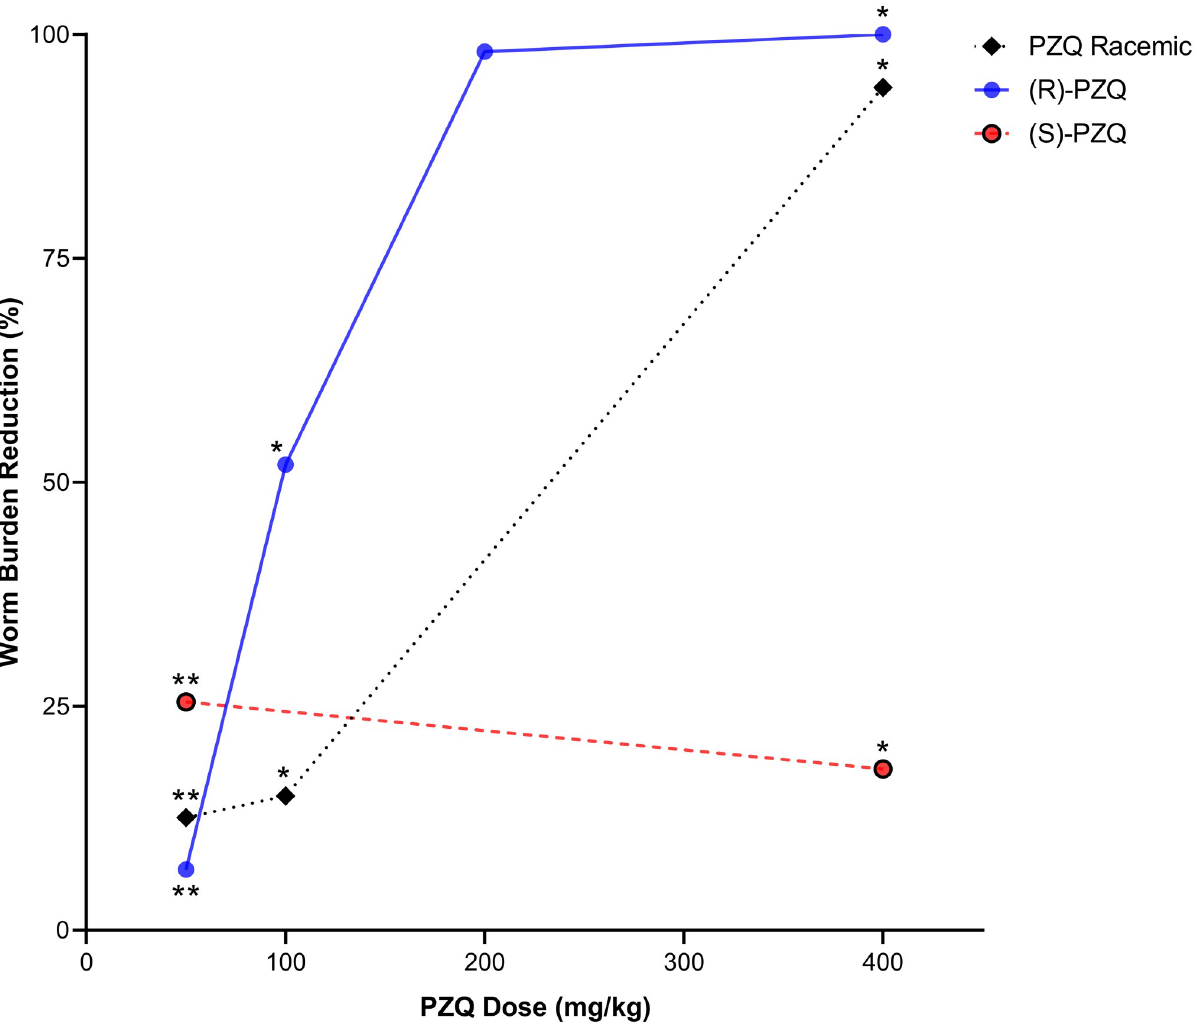
Fig 2. Comparison of the percentage WBR in an infected mouse model when dosing racemic PZQ or a single enantiomer. The data for this graph were extracted from two papers in this review and evaluated to assess the WBR-dose response [49, 50]. The relationship between WBR and drug formulation was found to be significantly different ( � P < 0.01, �� P < 0.001) for each PZQ dose based on the results of the independent samples Kruskal-Wallis Test. PZQ, praziquantel; WBR, worm burden